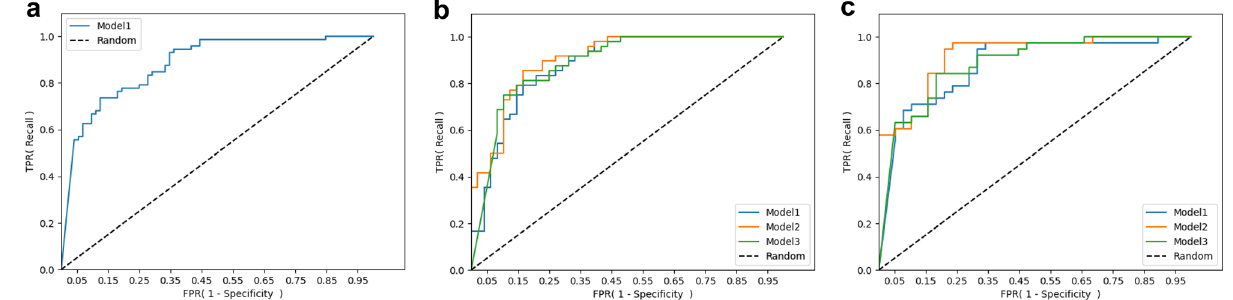
Figure 2. Receiver operating characteristic curves of proposed ML models for ( a ) NEC prediction, ( b ) NEC-IP prediction, and ( c ) SIP prediction.